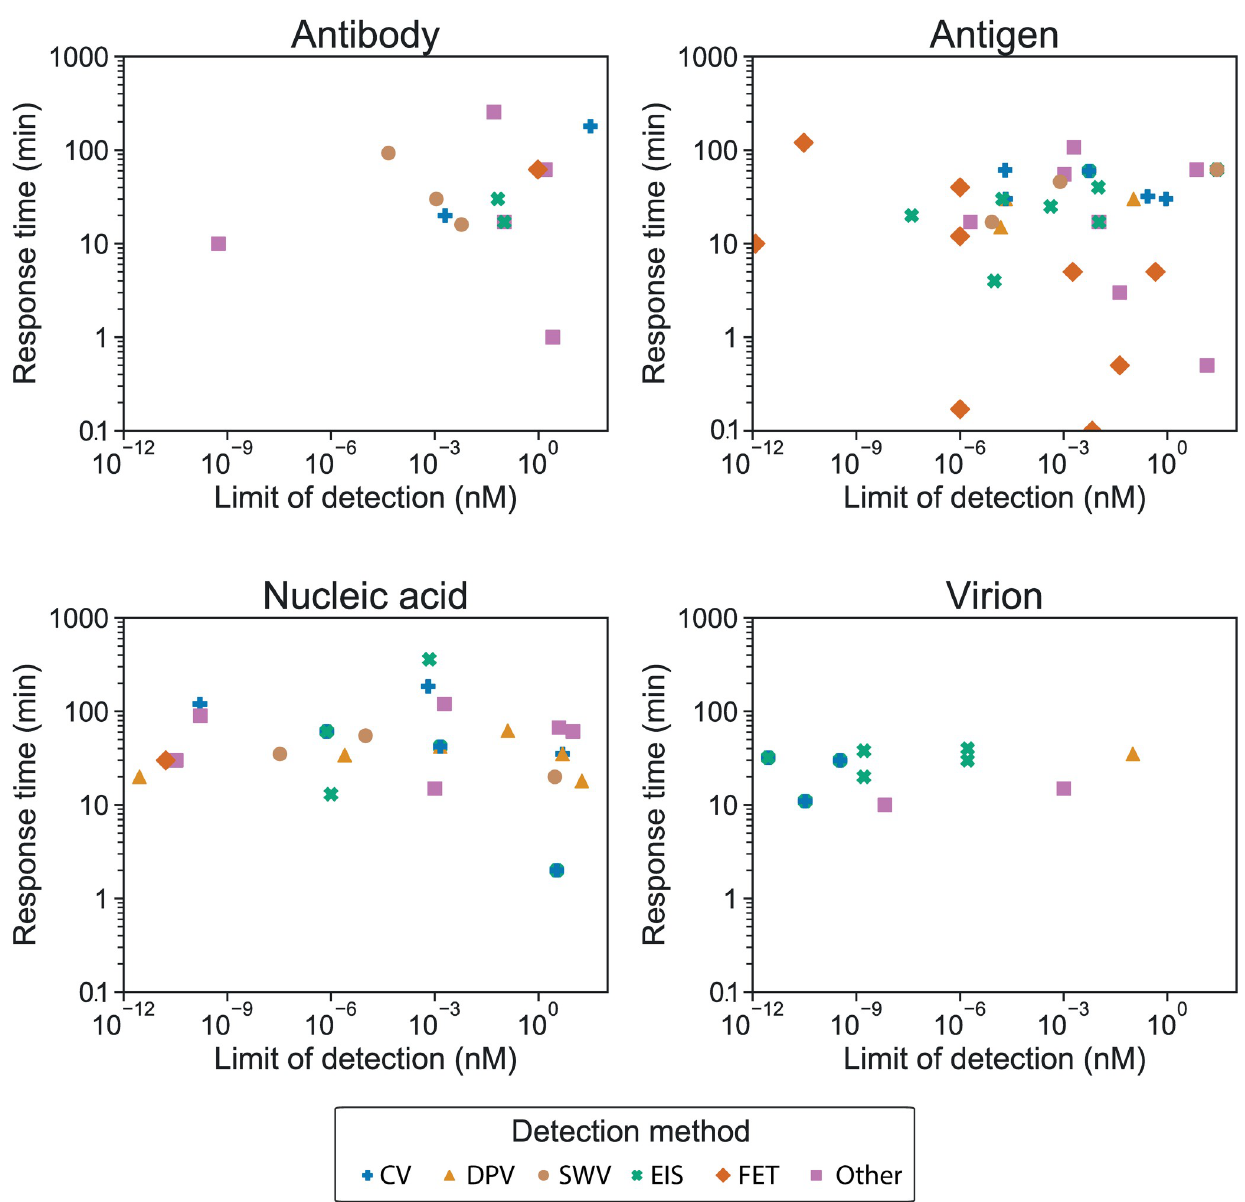
Fig 4. Sensor properties represented as response time vs. detection limit, by detection method. Only papers from our review presenting a limit of detection in nM or convertible to nM are included in this graph. The results for different targets are shown in different sub-plots: antibody (A), antigen (B), nucleic acid (C) and virion (D); separated by detection method: CV (blue plus), DPV (gold triangle), SWV (brown circle), EIS (green cross), FET (orange diamond), other (purple square).